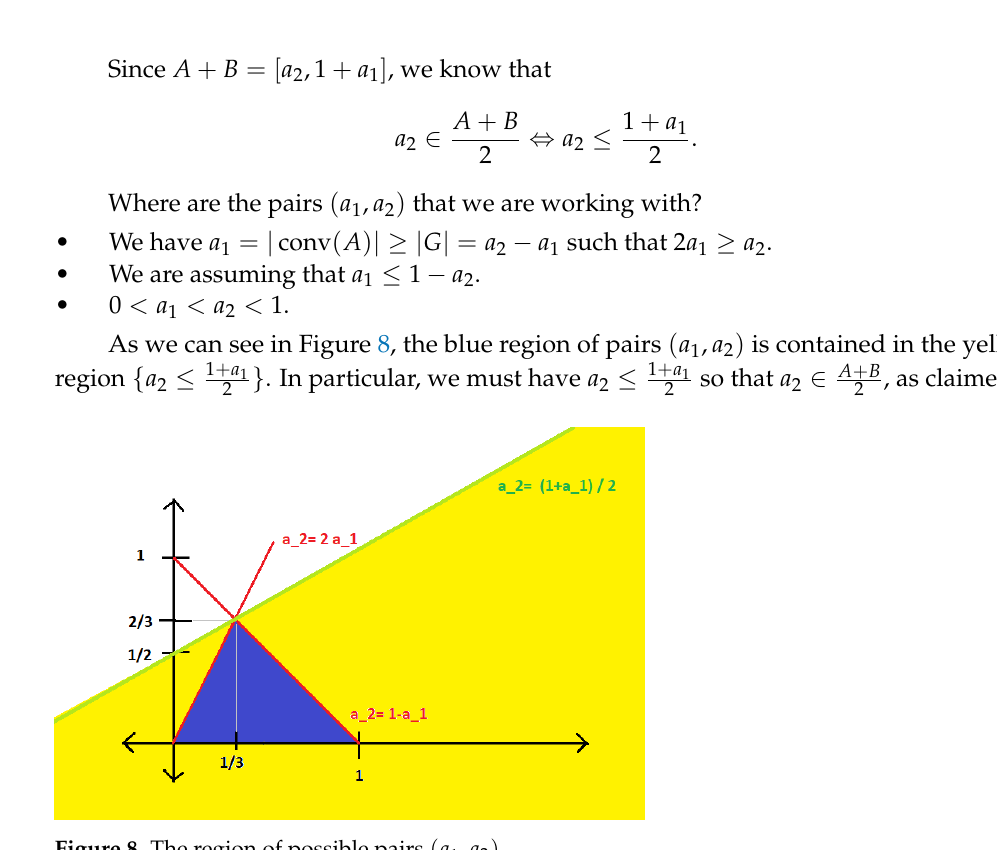
Figure 8. The region of possible pairs ( a 1 , a 2 )